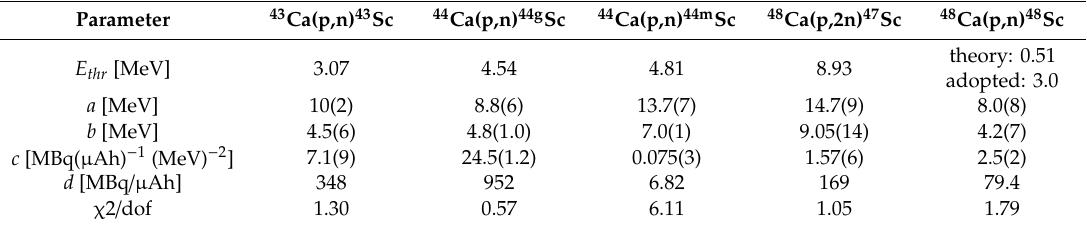
Table 2. Parameters of the TTY fit (for Figures 1–5) obtained with least square method for di ff erent nuclear reactions and the χ 2 / dof values for each fit. Parameter d is calculated from a , b , c and E thr